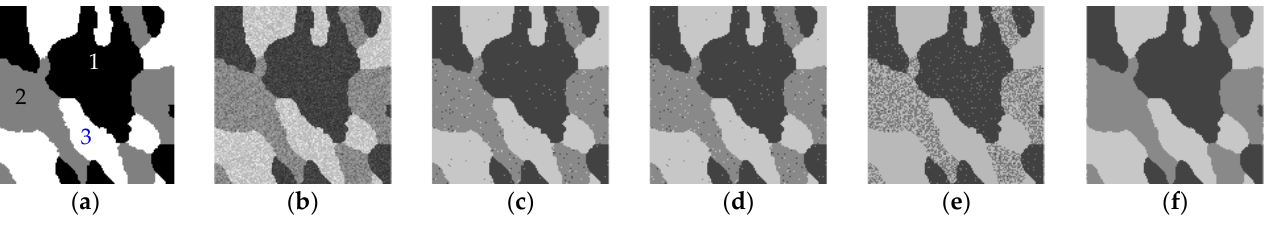
Figure 3. The segmentation experiment of the simulated image. ( a ) the template image, and 1 – 3 are the labels of regions, ( b ) the simulated image, ( c ) FCM algorithm, ( d ) GMM algorithm, ( e ) SMM algorithm, ( f ) HSMM algorithm. Table 1. The parameters of generating the simulated image.